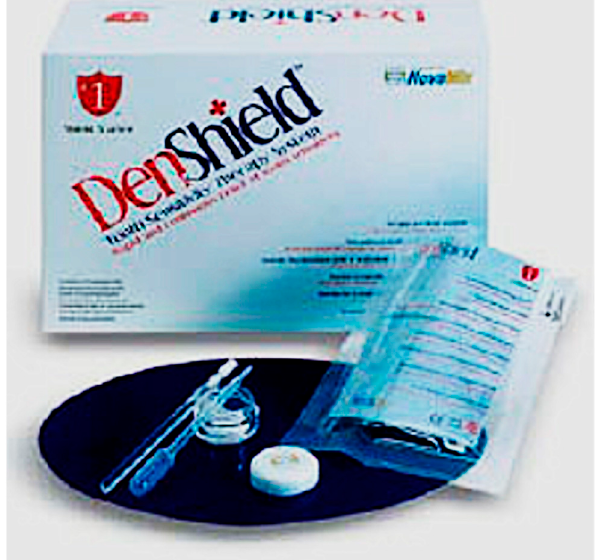
Figure 1. NovaMin ® paste prepared by mixing pure novamin powder (Denshield; Shield Starter) and with distilled water.